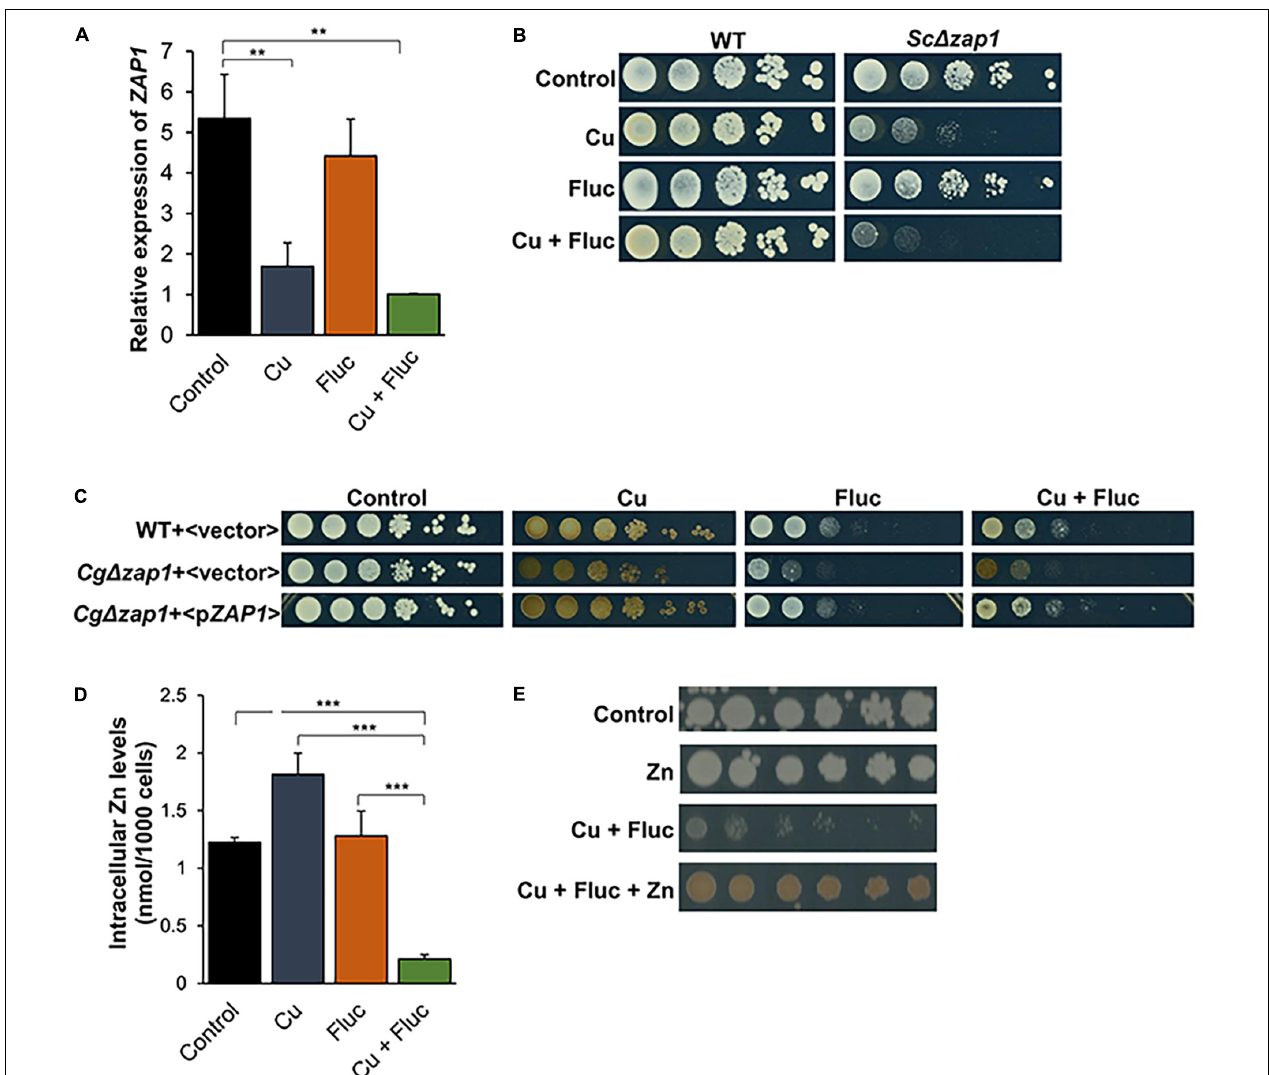
FIGURE 8 | Zinc homeostasis and the transcription factor Zap1 are relevant for cells to thrive under Cu + Fluc conditions. (A) The expression of ZAP1 gene in Candida glabrata cells left untreated (Control), treated with 1.25 mM CuSO 4 (Cu), 32 µ g/mL fluconazole (Fluc), or with a combination of Cu and Fluc (Cu + Fluc) was evaluated by qRT-PCR. (B) Growth of Saccharomyces cerevisiae wild-type (WT) (WT:BY4742) and (cid:49) zap1 mutant strains in SC agar plates (Control) containing 4 µ g/mL of fluconazole (Fluc), 625 µ M CuSO 4 (Cu), or a combination of both (Cu + Fluc). Growth was recorded after 96 h at 30 ◦ C. (C) Growth of Candida glabrata WT and (cid:49) zap1 mutant strains transformed with a plasmid containing the Cg ZAP1 gene under the control of its native promoter ( < p ZAP1 > ) or with the empty vector ( < vector > ) in SC agar plates lacking tryptophan (Control) containing 32 µ g/mL of fluconazole (Fluc), 625 µ M CuSO 4 (Cu), or a combination of both (Cu + Fluc), after 48 h at 37 ◦ C. (D) The zinc content of cells untreated (Control) or treated with 625 µ M CuSO 4 (Cu), 32 µ g/mL fluconazole (Fluc), or a combination of both was measured by ICP-AES. (E) Effect of zinc on the growth sensitivity of Candida glabrata cells to Cu + Fluc. Cells were serial diluted and spotted on SD plates containing a mixture of fluconazole (32 µ g/mL) and CuSO 4 (625 µ M), supplemented (Cu + Fluc + Zn), or not (Cu + Fluc) with 4 mM of ZnSO 4 . Growth was recorded after 48 h at 37 ◦ C. Significance of differences was calculated using student’s T -test (** p -value < 0.05; *** p -value <